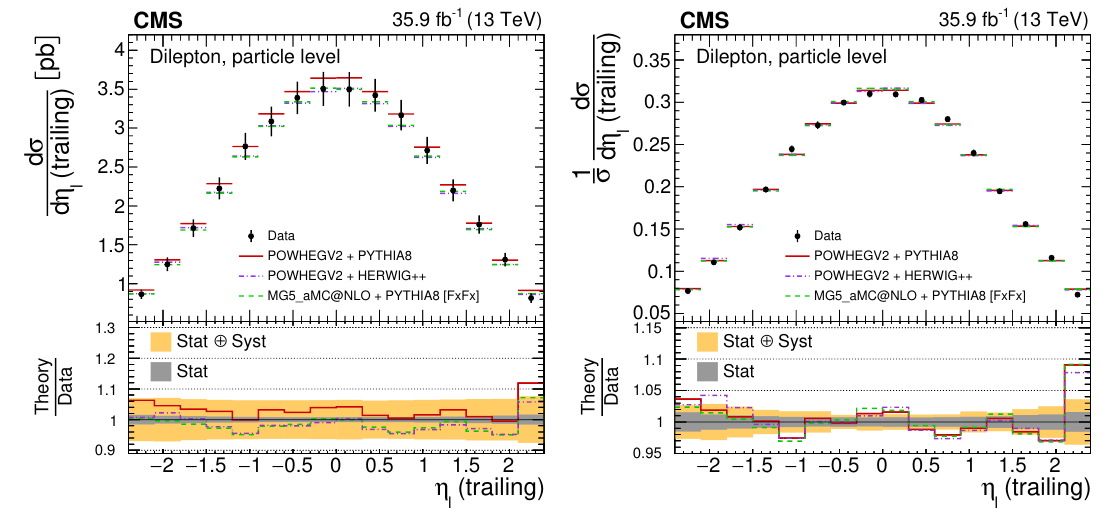
Figure 40 . The di(cid:11)erential tt production cross sections as a function of (cid:17) ‘ (trailing) in a (cid:12)ducial phase space at the particle level are shown for the data (points) and the MC predictions (lines). The vertical lines on the points indicate the total uncertainty in the data. The left and right plots correspond to absolute and normalised measurements, respectively. The lower panel in each plot shows the ratios of the theoretical predictions to the data. The dark and light bands show the relative statistical and total uncertainties in the data, respectively.